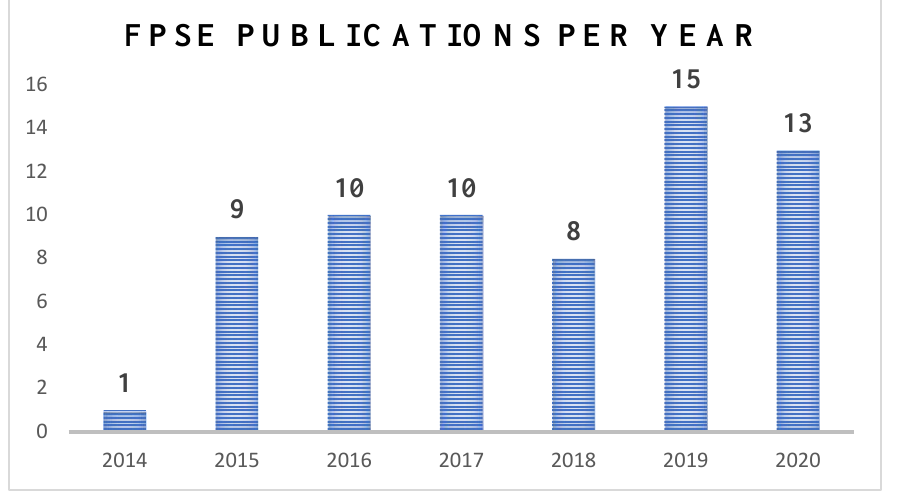
Figure 3. Graphical representation of number of papers published on FPSE per year since 2014.